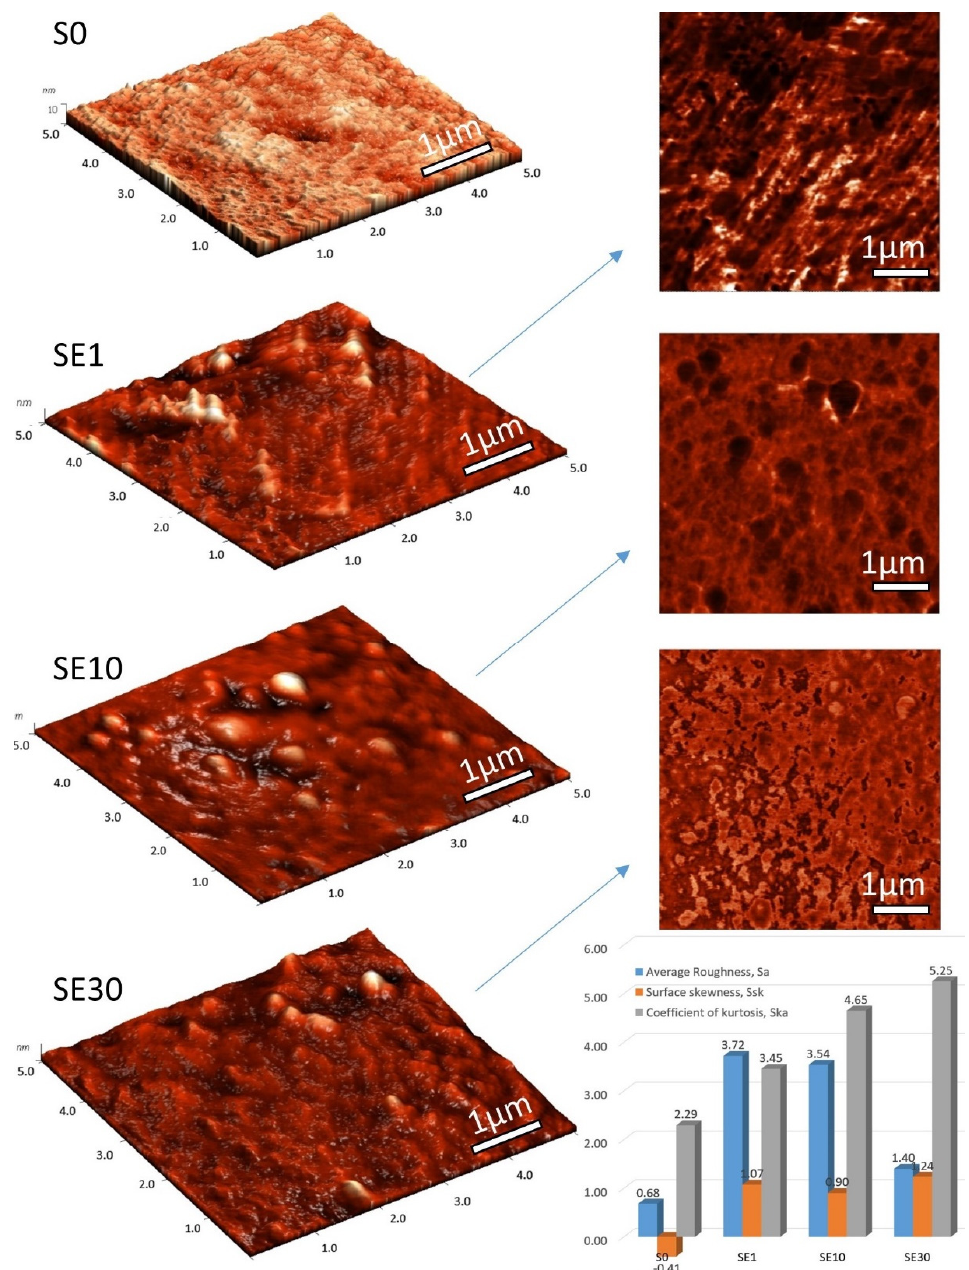
Figure 2. AFM images of S0 Ref unmodified membrane and PFSA–RF samples using an ethanol–water mixture as the solvent in the impregnation process: 3D images and the corresponding phase contrast images on 5 µm * 5 µm scan areas. Graph representing average roughness (nm), surface skewness, and coefficient of kurtosis resulted from the data-processing of the AFM image.